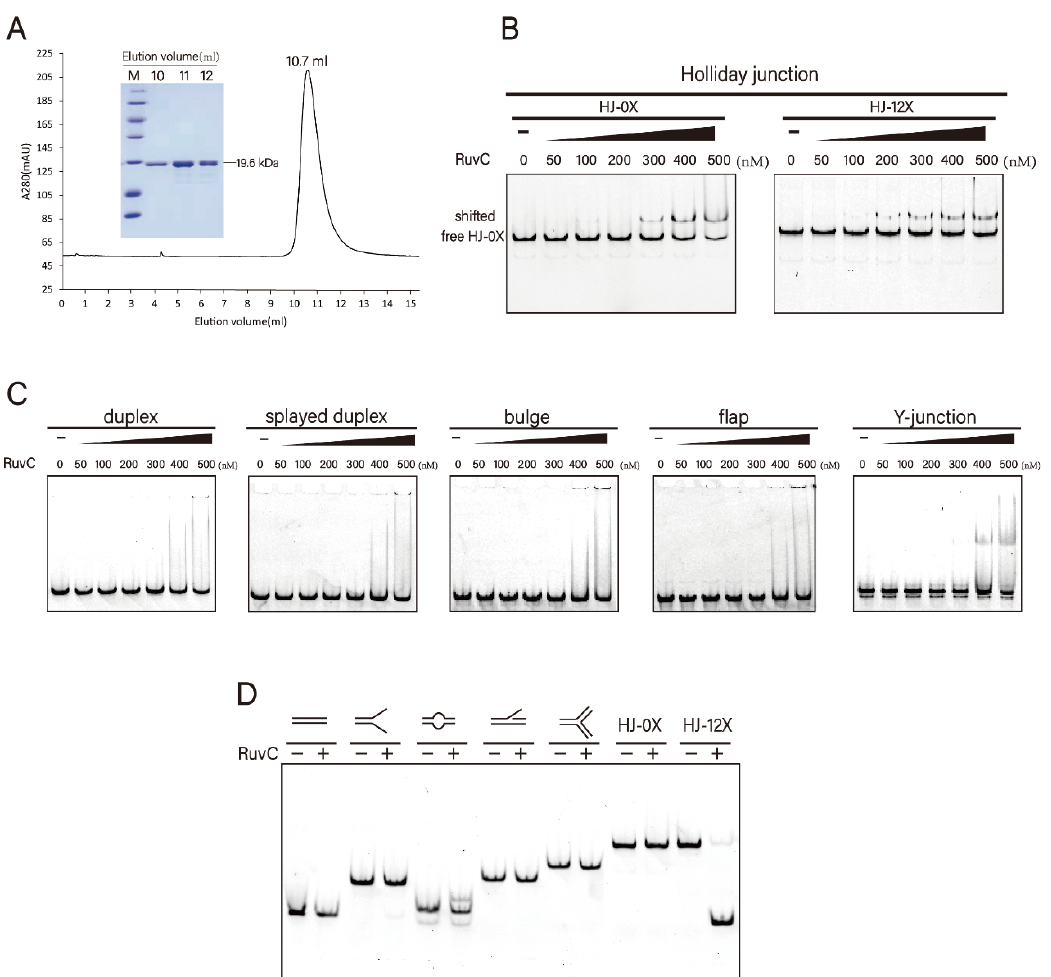
Figure 1. Protein purification and substrate specificities of Dr RuvC. ( A ) Size exclusion chromatogram (Superdex 75 10/300 GL column) of recombinant Dr RuvC protein. SDS-PAGE of representative eluted fractions is shown in inset. ( B ) Bandshift analysis of Holliday junctions (HJ-0X and HJ-12X). ( C ) Bandshift analysis of the indicated DNA structures. From left to right, the binding reactions contained 0, 50, 100, 200, 300, 400, 500 nM of Dr RuvC protein. ( D ) Native PAGE analysis of Dr RuvC cleavage of the indicated DNA structures.